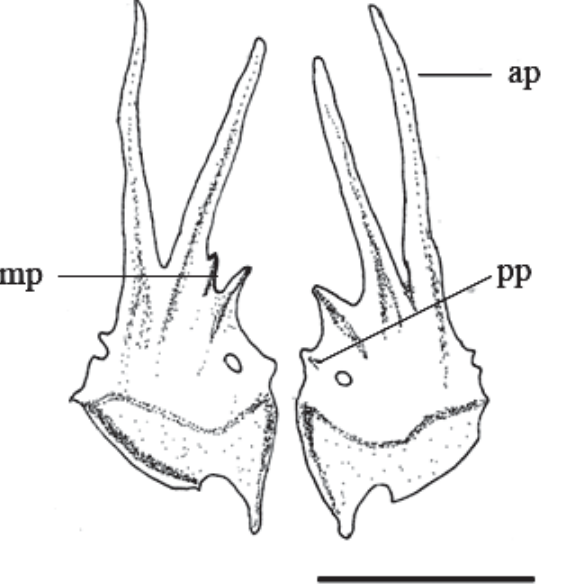
Fig. 7. Ventral view of the basipterygium of Trichomycterus uisae . CAC-CDMB 90, 41.1 mm SL. ap: anterior process; mp: medial process; pp: posterior process. Scale bar = 1 mm.